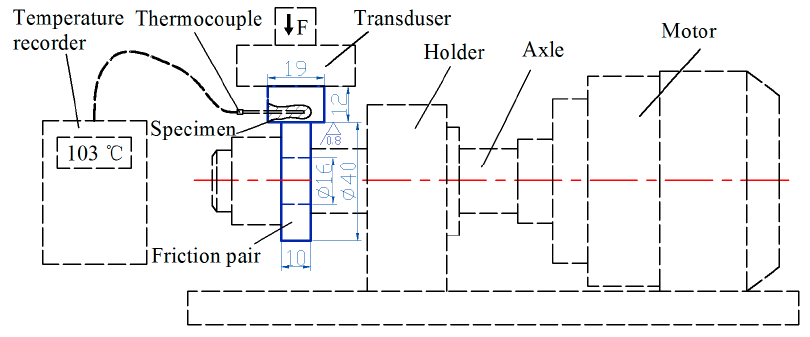
Figure 2. Size of the wear specimens and configuration of the wear tester.